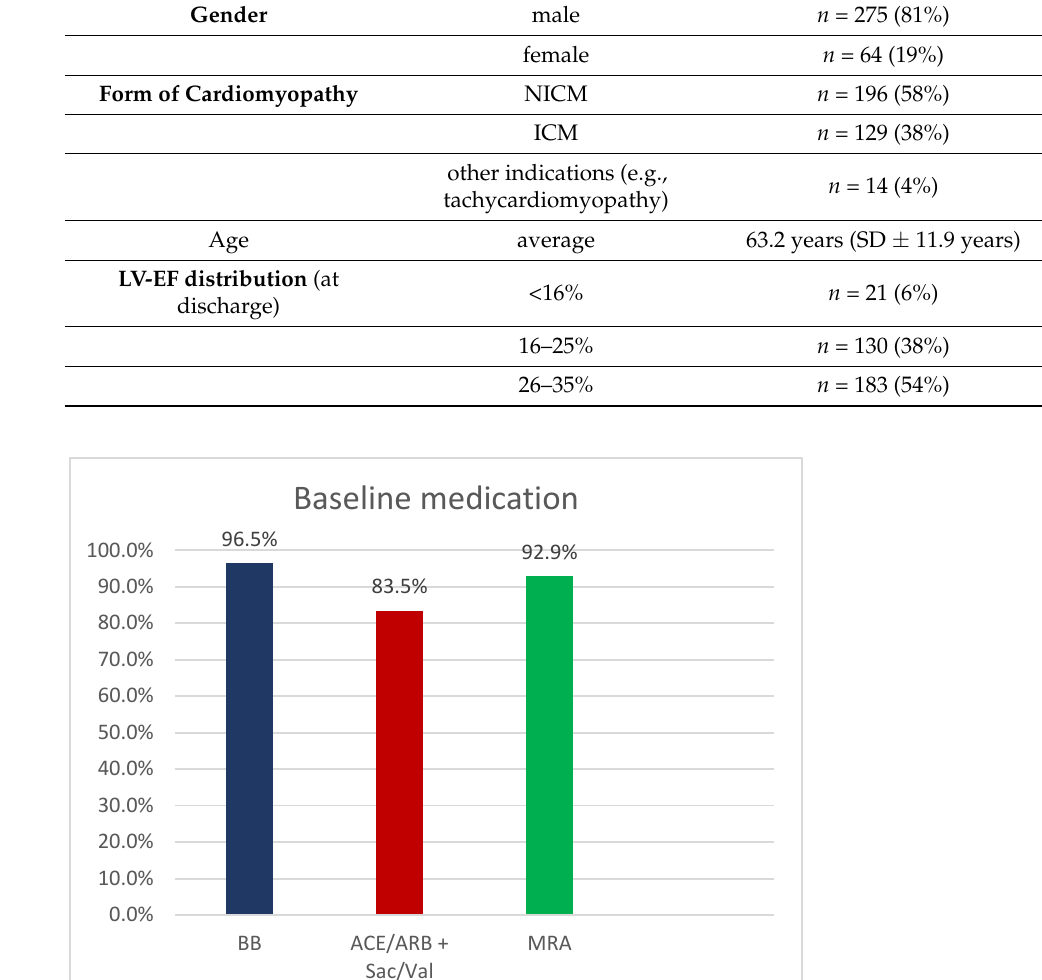
Figure 1. Baseline medication at discharge. BB = Betablocker, ACE = ACE-Inhibitor, ARB = Angiotensin-receptor blocker, MRA = Mineralcorticoidreceptorantagonists, Sac/Val = Sacubitril/Valsartan. The percentage of uptitration was, after 8 weeks, lower than after 4 weeks.